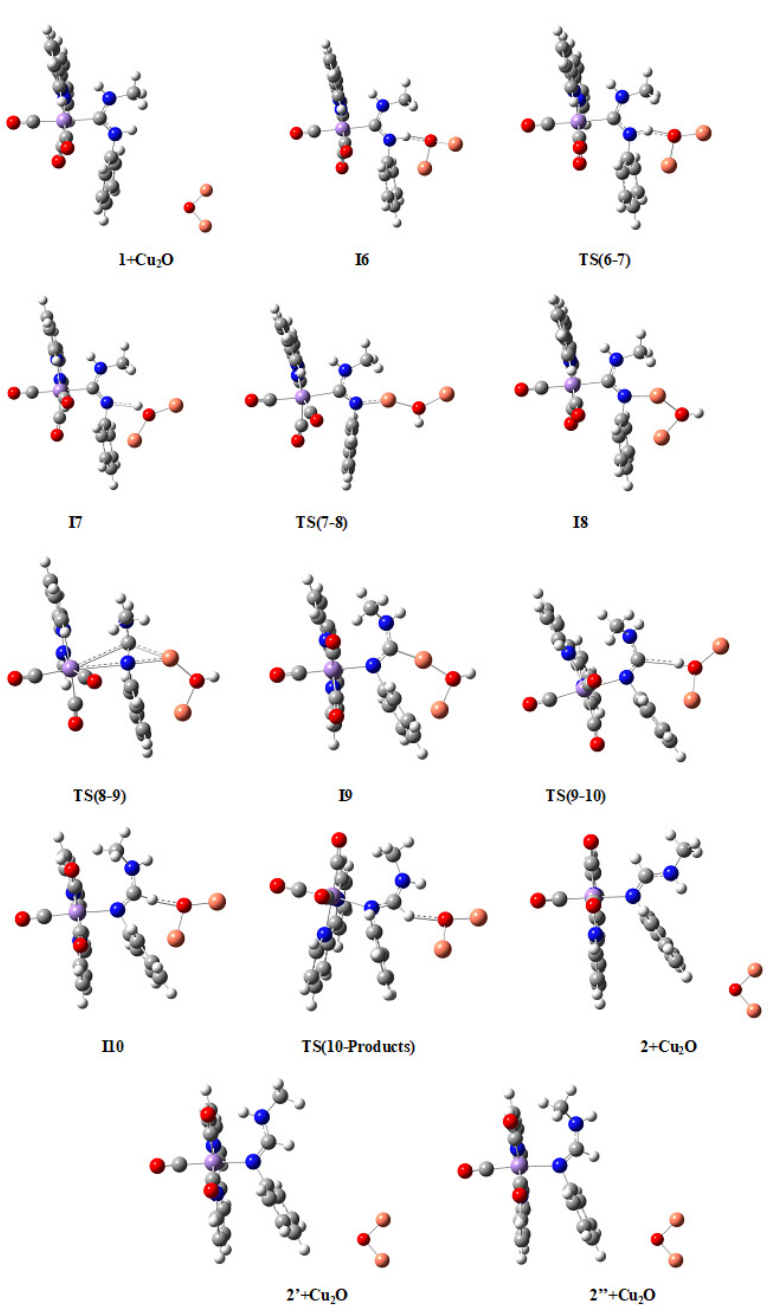
Figure 6. Molecular structures of compounds in the M2 mechanism. Larger figures are given in the Supplementary Material (Figure S2). Color codes: Mn (magenta), C (grey), O (red), N (dark blue), H (white), and Cu (coppery).